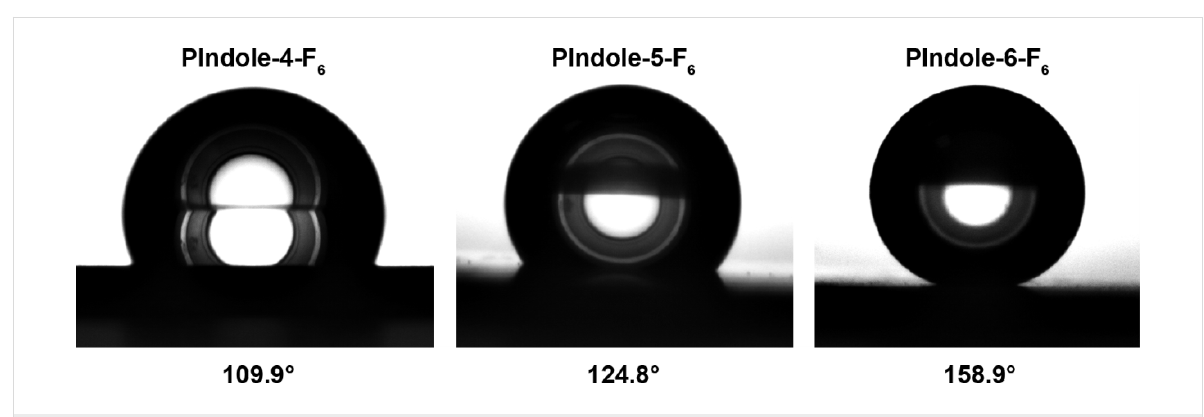
Figure 5: Image of a water droplet deposited on PIndole-4-F 6 , PIndole-5-F 6 and PIndole-4-F 6 ; Qs = 100 mC·cm − 2